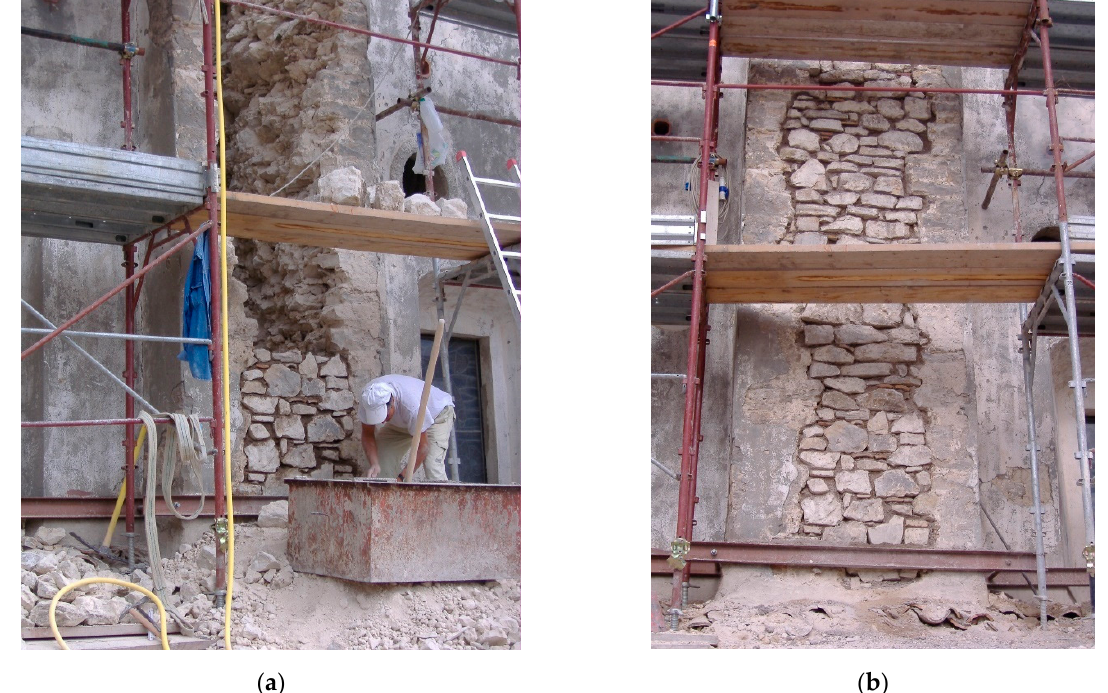
Figure 7. Application of the indention technique to the strengthening of a parastas: ( a ) during the intervention; ( b ) at the end of the intervention.